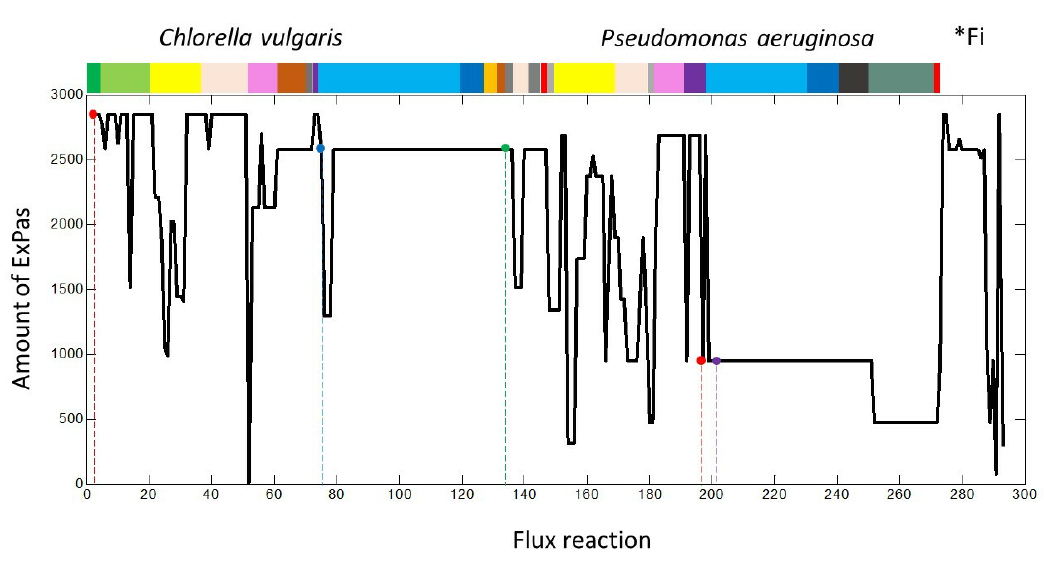
Figure 2. Participation of flux reaction in the extreme pathways. * Fi: exchange fluxes. Piext ( • ), PO 4 ext ( • ), NO 3 ext ( • ) and NH 3 ext ( •